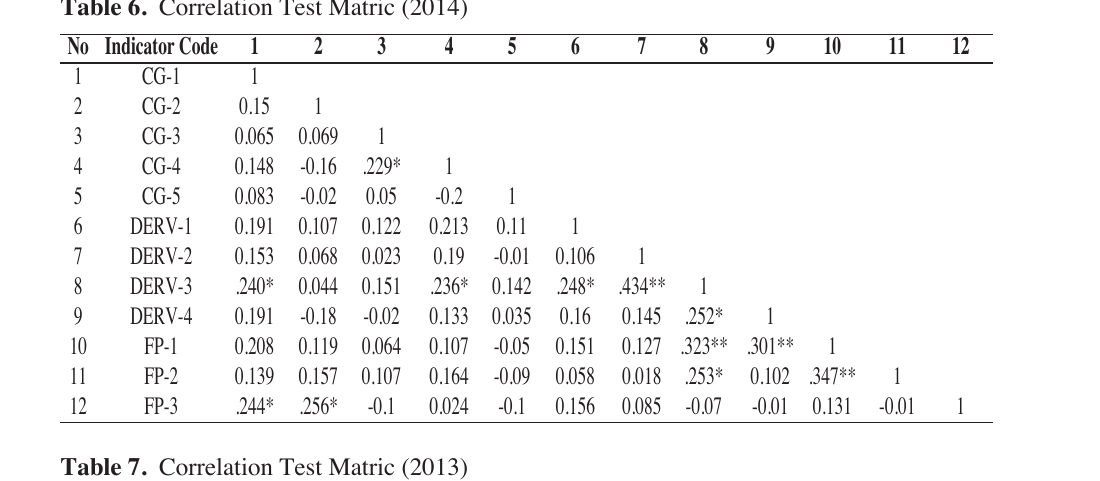
Table 7. Correlation Test Matric (2013)